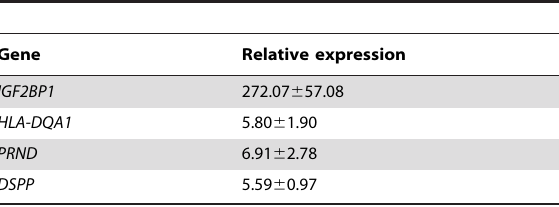
Table 3. mRNA expression ratios for deciduous/permanent dental pulp tissues.